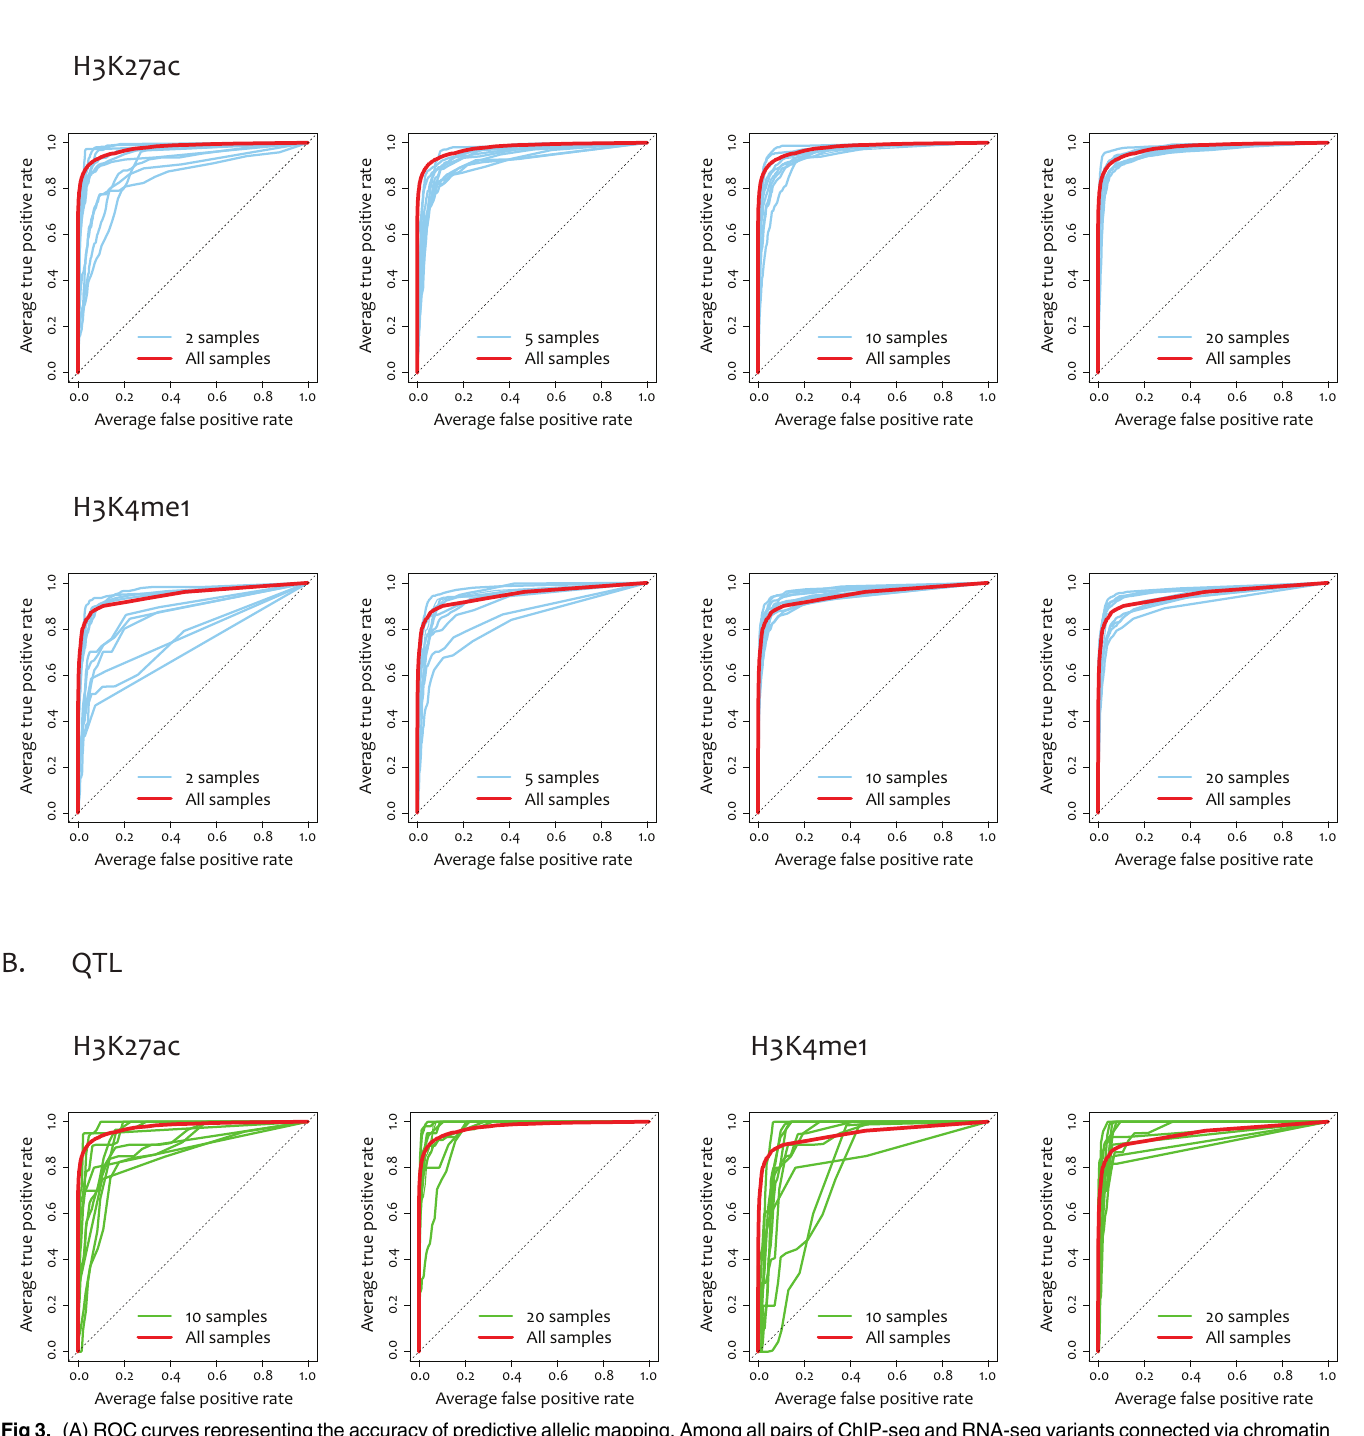
PLOS ONE | https://doi.org/10.1371/journal.pone.0175768 April 13,